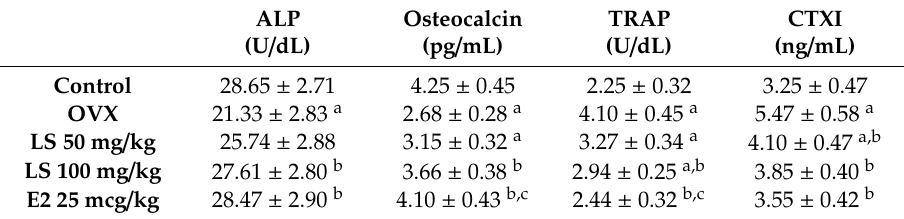
Table 1. E ff ect of L. sativum on serum markers of bone formation and